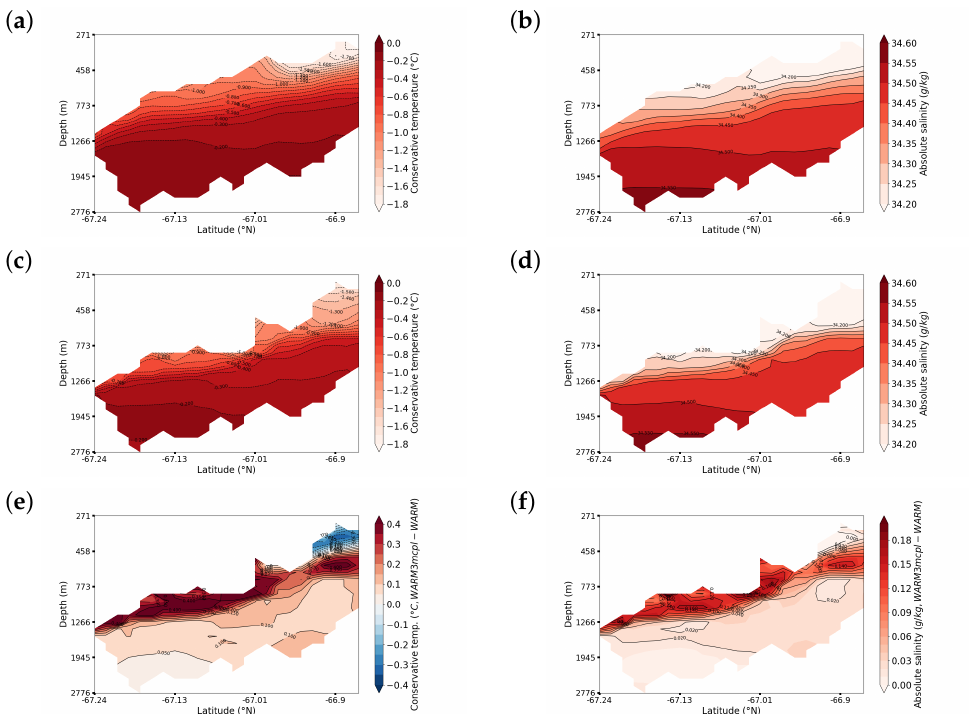
Figure A6. Cross-sections in the TIS cavity of ocean temperature for WARM3mcpl ( a ) and WARM ( c ), and of ocean temperature difference between WARM3mcpl and WARM ( e ). Cross-sections in the TIS cavity of ocean salinity for WARM3mcpl ( b ) and WARM ( d ), and of ocean salinity difference between WARM3mcpl and WARM ( f ). All averaged over the 20-year simulations. The section is shown in ( a